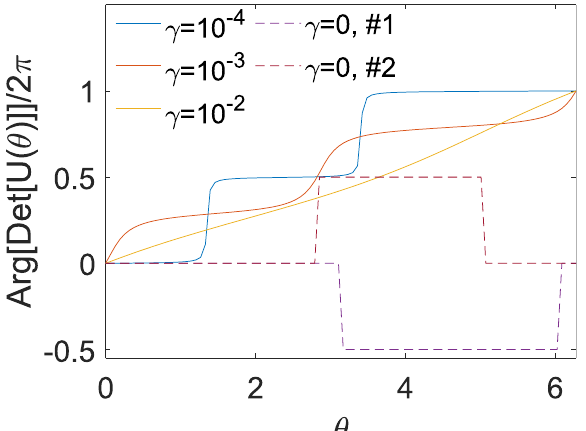
Figure 3. The argument flow, Arg (det U ( θ )) in case of strong phase disorder Φ max = π for the GHN ( γ > 0, solid lines) and RC ( γ = 0, dashed lines) models. Five representative realizations are